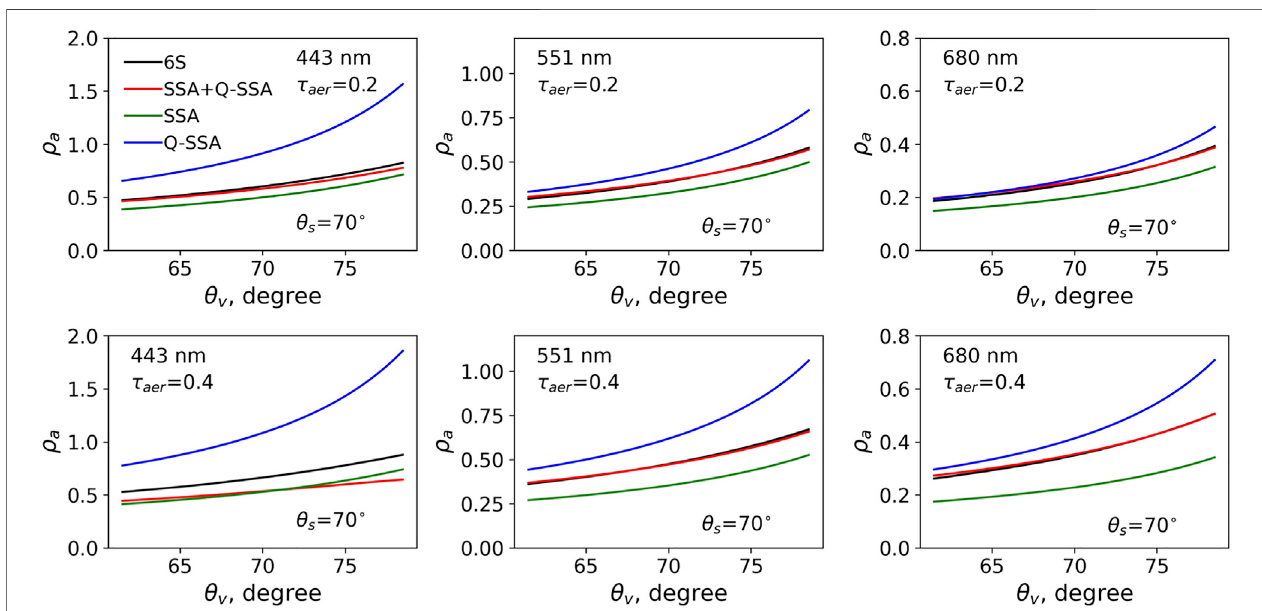
FIGURE 1| Atmospheric re fl ectance ρ a parameterization using SSA, Q-SSA, and acombination of SSAand Q-SSA (green, blue, and black dots, respectively). 6S calculations (RT) are displayed as red curves. Sun zenith angle is 70 deg., scattering angle is 171.5 deg., aerosols are of maritime type with optical thickness of 0.2 and 0.4 at 550 nm, and wavelengths are 388, 551, and 680 nm.